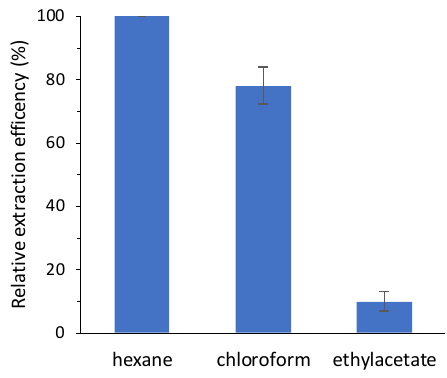
Figure 3. Relative extraction efficiency of derivatized trans -RSV with different organic solvents. Relative extraction efficiency of the organic solvents was obtained by setting the highest trans -RSV: methyl heptadecanoate peak area ratio equal to 100% ( n = 3; mean ± SD).